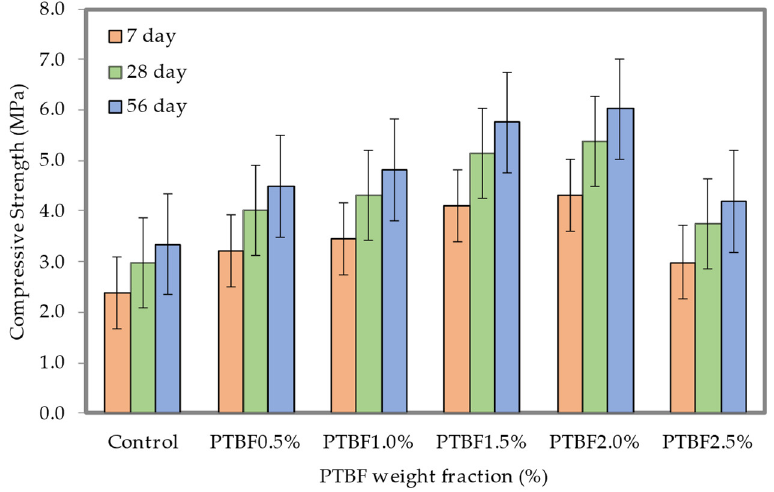
Figure 14. Compressive strength of 900 kg/m 3 density LFC with different weight fractions of PTBF.